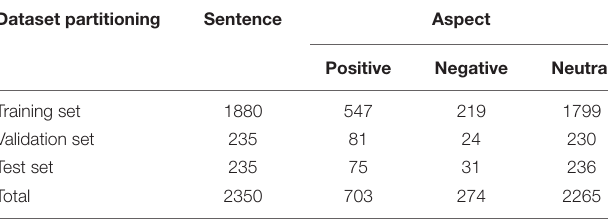
TABLE 2 | Specific distributions of semantic aspects in the TikTok datasets. Dataset partitioning